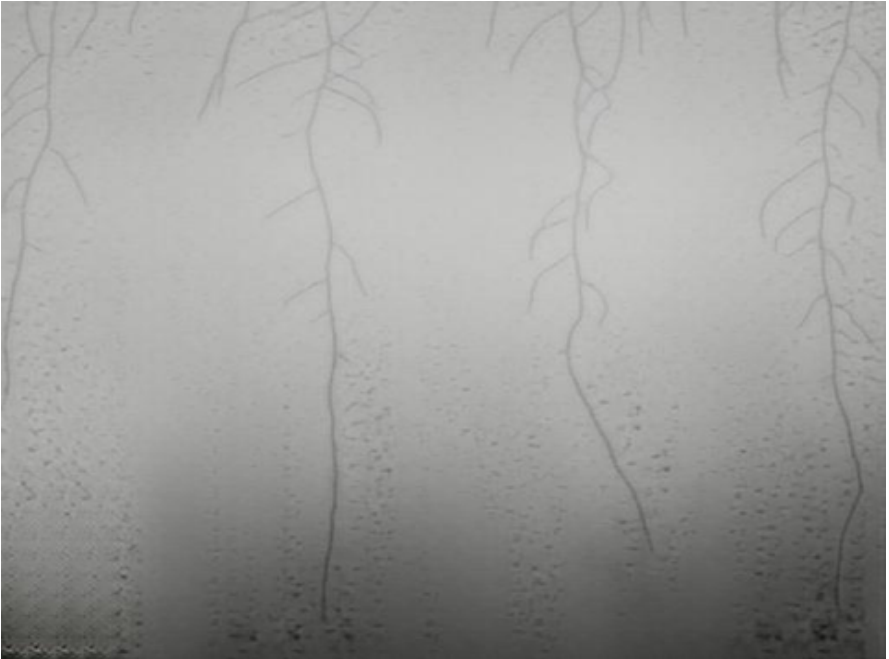
Figure 9. Corresponding original generated image as Figure 11. This image is used as example to show segmentation results of our trained SegNet model.